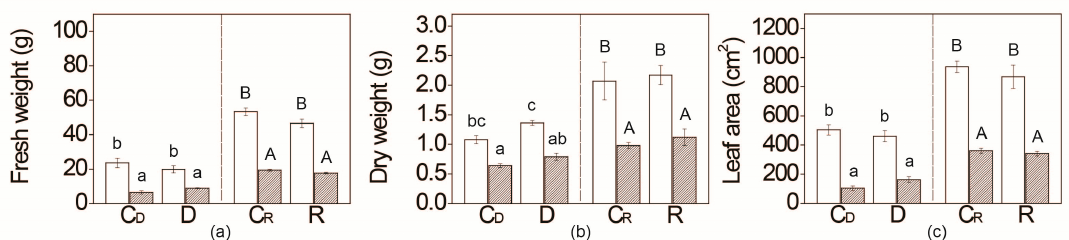
Figure 2. Total shoot fresh weight, FW ( a ) and dry weight, DW ( b ) per plant and leaf area ( c ) of WT (white bars) and flacca (patterned bars) tomato genotypes subjected to six day water deficit (D) period followed by a six day period of re-watering (R). Respective controls corresponding to water deficit condition (C D ) and re-watering (C R ) are presented. Values are presented as means ± SE ( n = 4). Different letters denote significant differences between means according to Tukey HSD post hoc test p ≤ 0.05. Small letters represent the differences in means of drought treatment, while capital letters represent re-watering treatment.